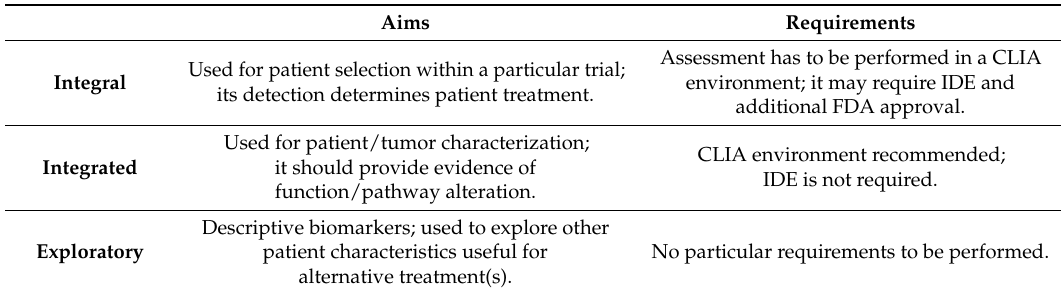
Table 2. Biomarkers definition.